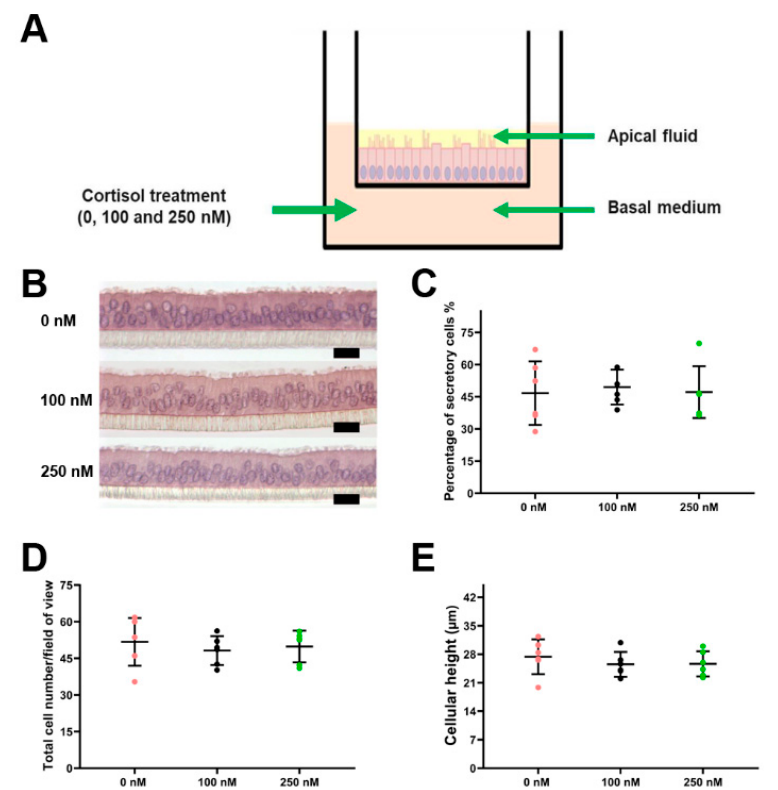
Figure 1. ALI-POEC morphology in response to long-term cortisol (100 and 250 nM) stimulation. ( A ) Schematic illustration of cortisol treatment in porcine oviduct epithelial cells grown at the air–liquid interface (ALI-POEC). ( B ) Representative cross-sections of ALI-POEC, hematoxylin–eosin (HE) staining, scale bar = 20 µ m; ( C ) percentage of secretory cells; ( D ) total cell number / field of view; ( E ) cellular height. Data are shown as mean with standard deviation (SD). n = six animals.